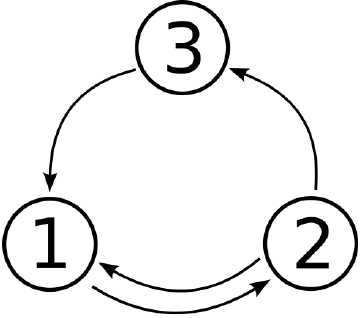
Figure 2. A schematic representation of a PSS guided by the SHC networks consisting of three states and the possible transitions between